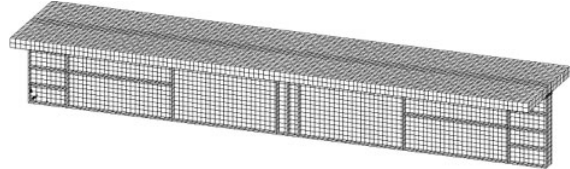
Fig. 5. Typical fi nite element mesh